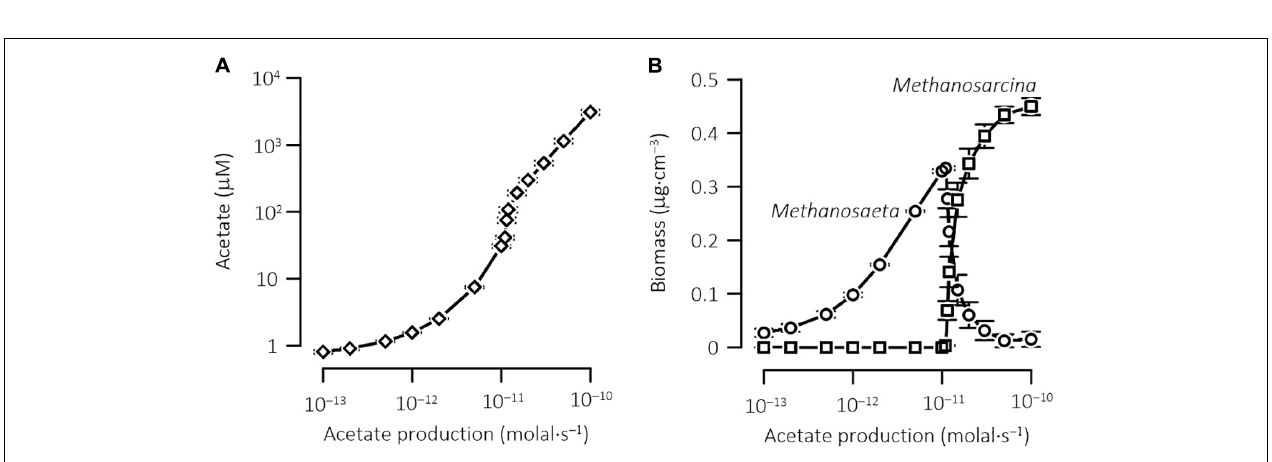
FIGURE 7 | Variations with acetate concentration in the rates of methanogenesis (A) and biomass synthesis per unit biomass (B) calculated according to the autocatalytic model (Eqs 2, 3, 6) and the parameters of laboratory methanogen cultures (see Table 1 ), and the rates of methanogenesis (C) calculated by combining the autocatalytic model (Eqs 2, 6) with the acclimation model (Eqs 16, 18). In evaluating the autocatalytic model (Eqs 2, 3, 6), the thermodynamic potential factor F T and the biomass capacity factor F X are set to 1, and the specific decay constant D is set at 0.